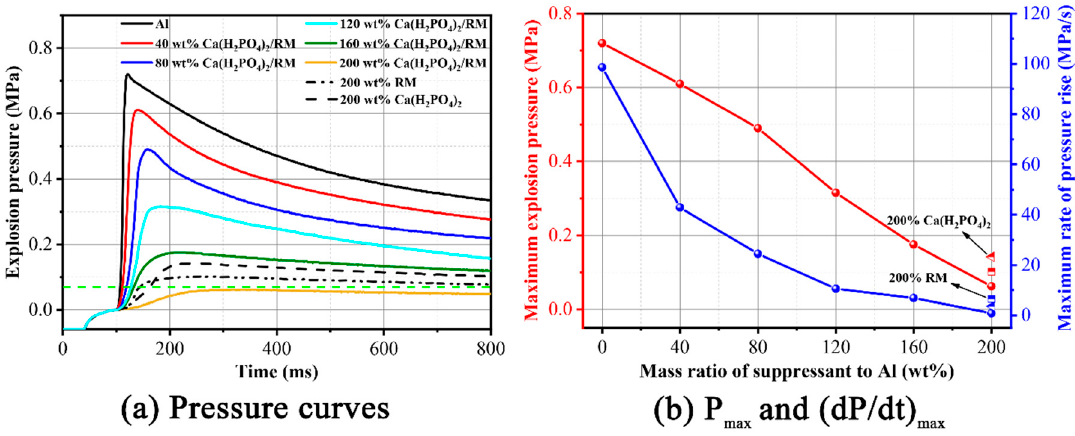
Figure 10. Suppression effect between suppressants: ( a ) pressure curve and ( b ) P max and ( dP/dt ) max values.